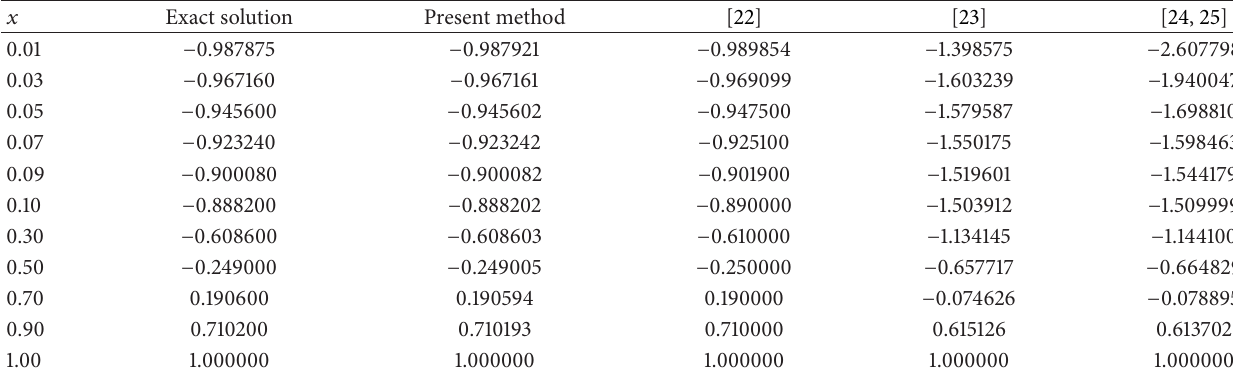
Table 3: Comparison of computed solution with [22–25] for Example 4.2 with 𝑁 = 100 and 𝜀 = 10 −3